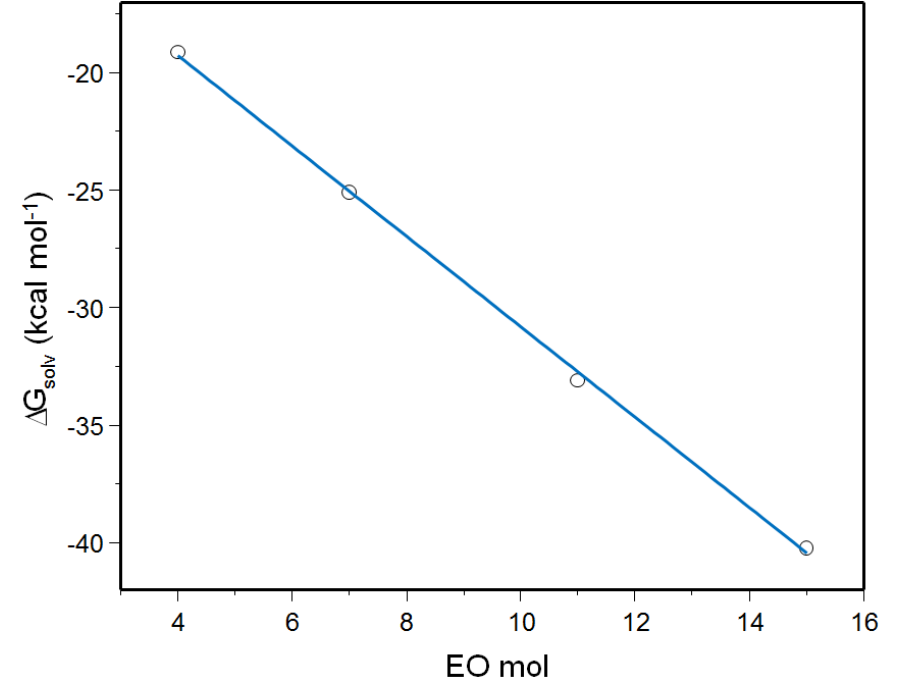
and EO units of NPE solv